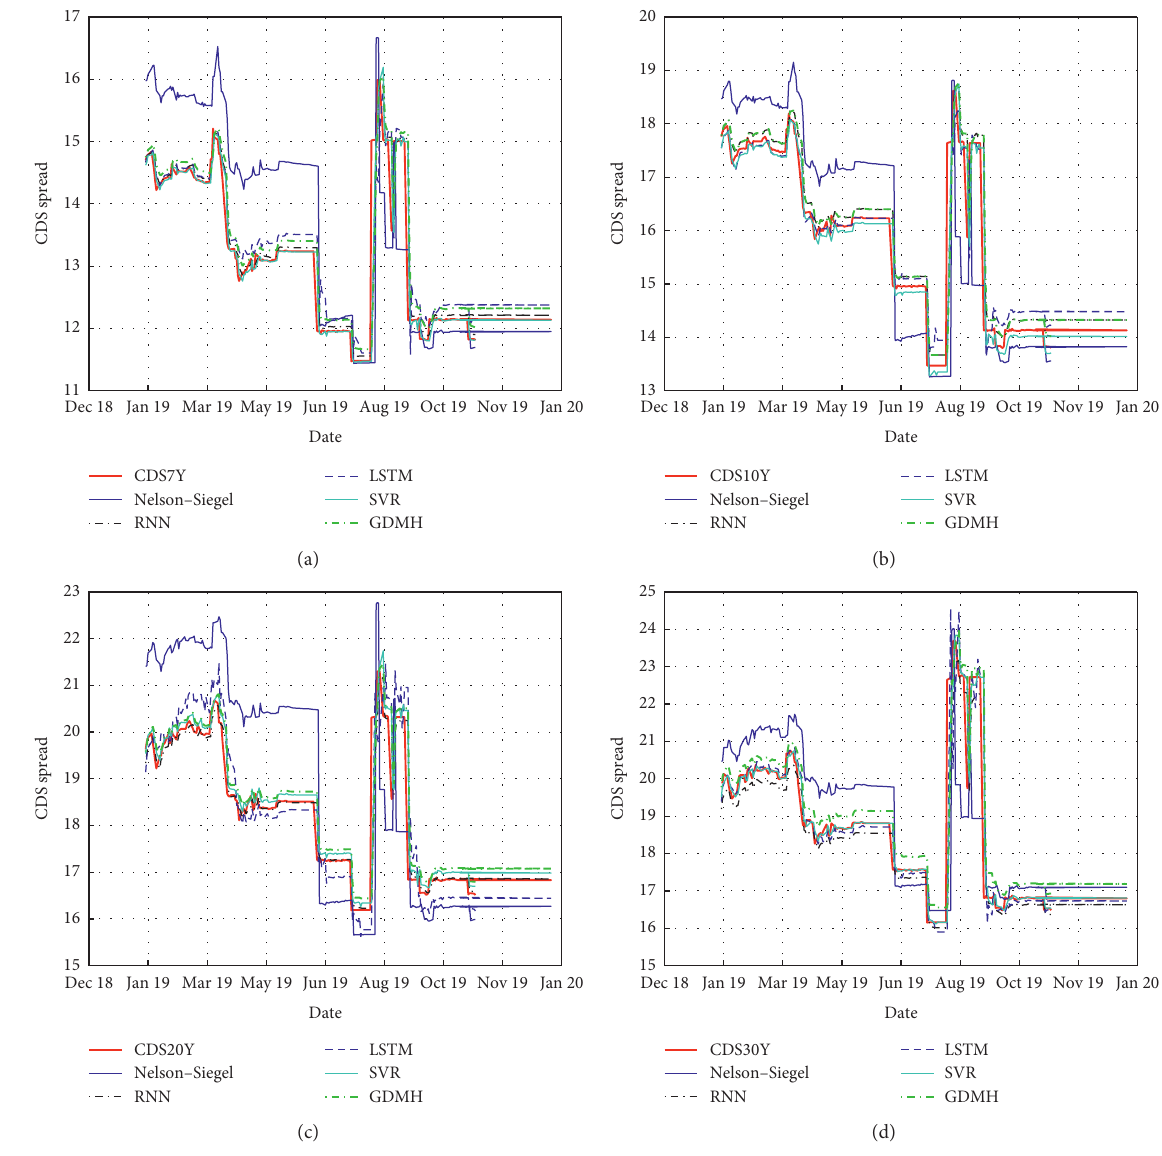
Figure 7: Predictions of each model and target CDS term structure from seven years to 30 years maturity for test dataset 1 with the full period training set (case